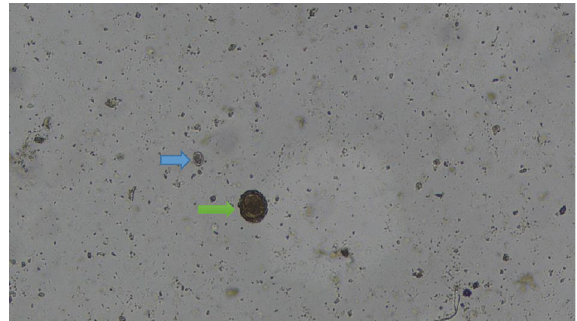
Figure 3: Ascaris suum (green allow) and coccidian cyst (blue arrow).